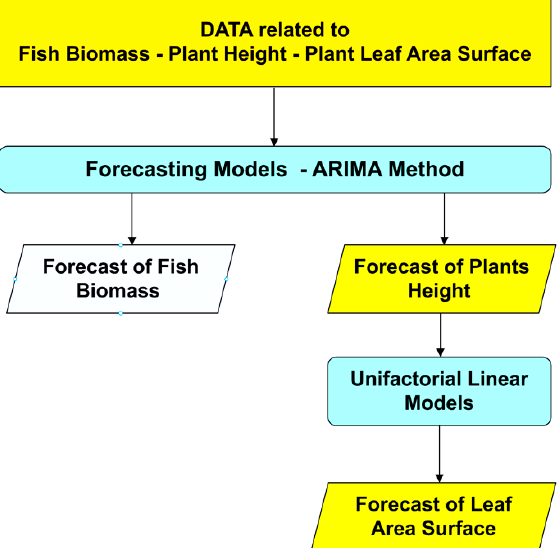
Figure 35. Analytical framework for data processing in order to elaborate fish and plants forecasting growth models.